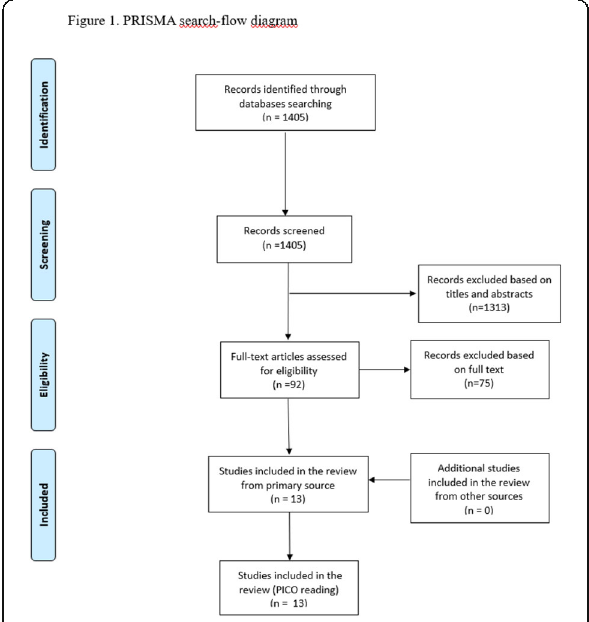
Fig. 1 (abstract P0160). See text for